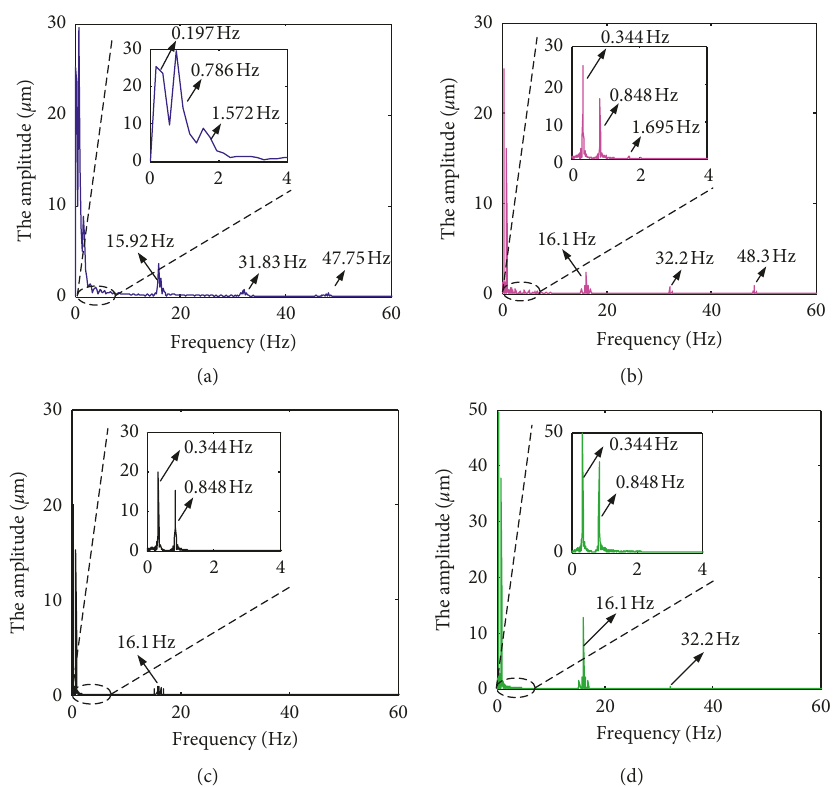
Figure 19: Spectrum and partial enlarged view of quasistatic transmission error: (a) experiment; (b) the measured manufacturing errors; (c) no manufacturing errors; (d) the given manufacturing